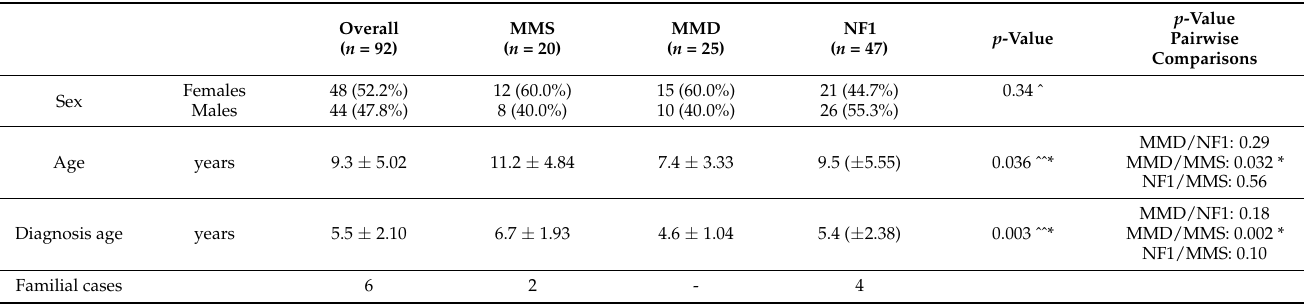
Table 1. Characteristics of the 92 patients enrolled in the